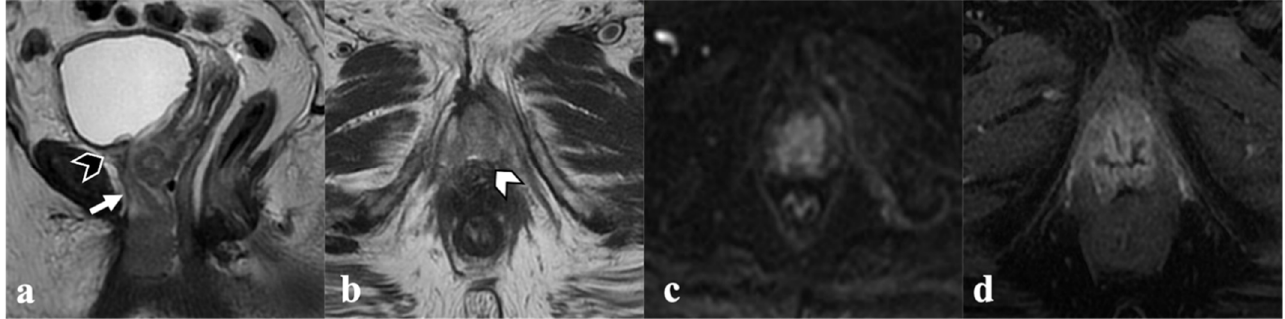
Figure 1. Locally advanced vulvar cancer. A 78-year-old patient with bulky tumor infiltrating both labia minora and majora (not shown), anteriorly, the urethra (( a )—white arrows) and the urinary bladder neck (( a )—black arrowhead), and cranially, the middle third of the vagina (( b )—white arrowhead). Mass also shows diffusion restriction ( c ) and contrast enhancement ( d ).